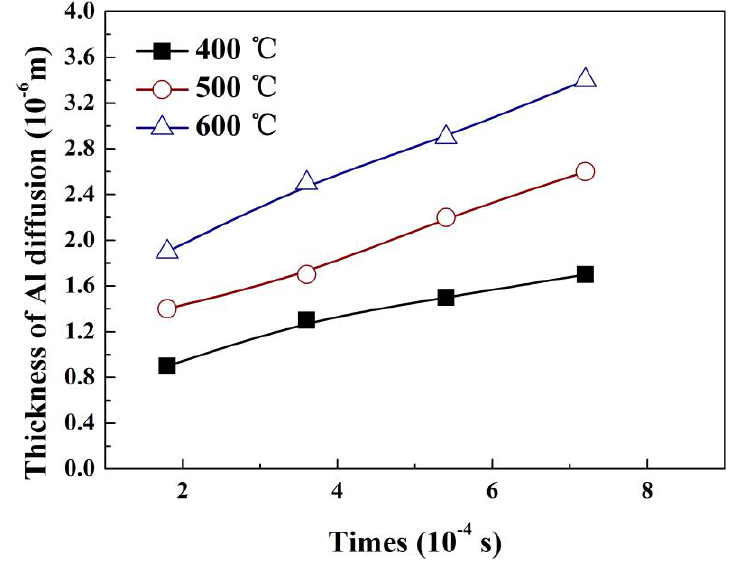
Figure 4. Diffusion thickness of Al atoms at different temperatures and times. Figure 4. Di ff usion thickness of Al atoms at di ff erent temperatures and